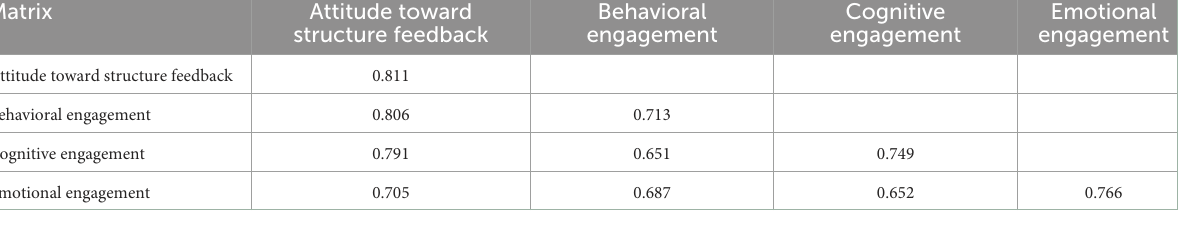
TABLE 9 Bootstrapping path